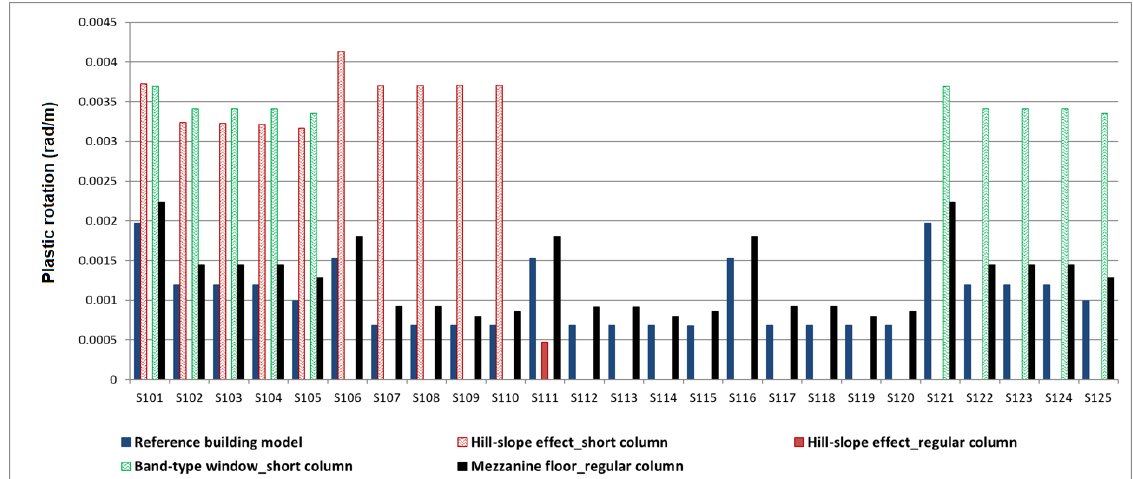
Figure 17. Comparison of plastic rotations.